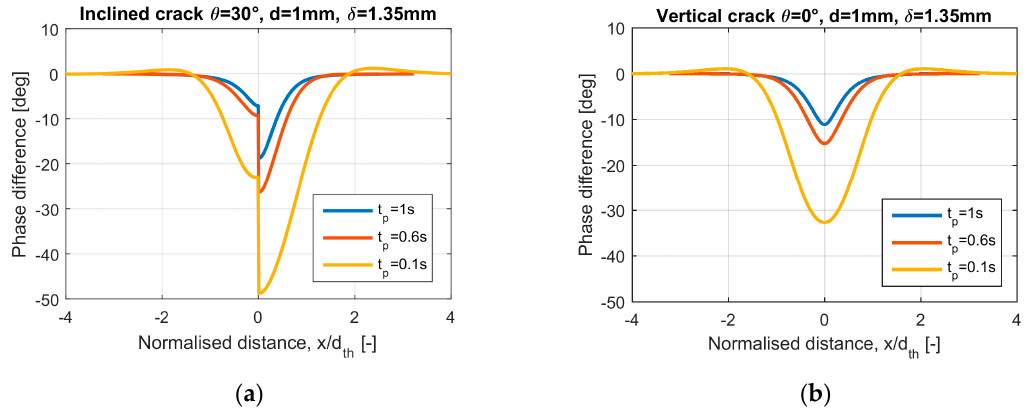
Figure 30. ( a ) Phase around the crack as shown in Figures 28 and 29 for different heating pulses; ( b ) phase for a vertical crack with the same d = 1 mm depth.